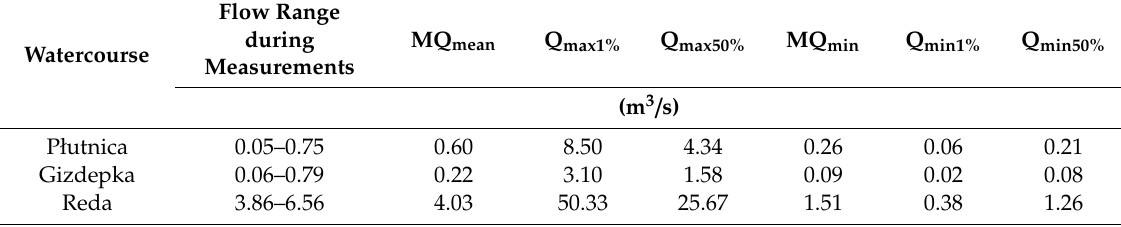
Table 1. Results of flow measurements and characteristic